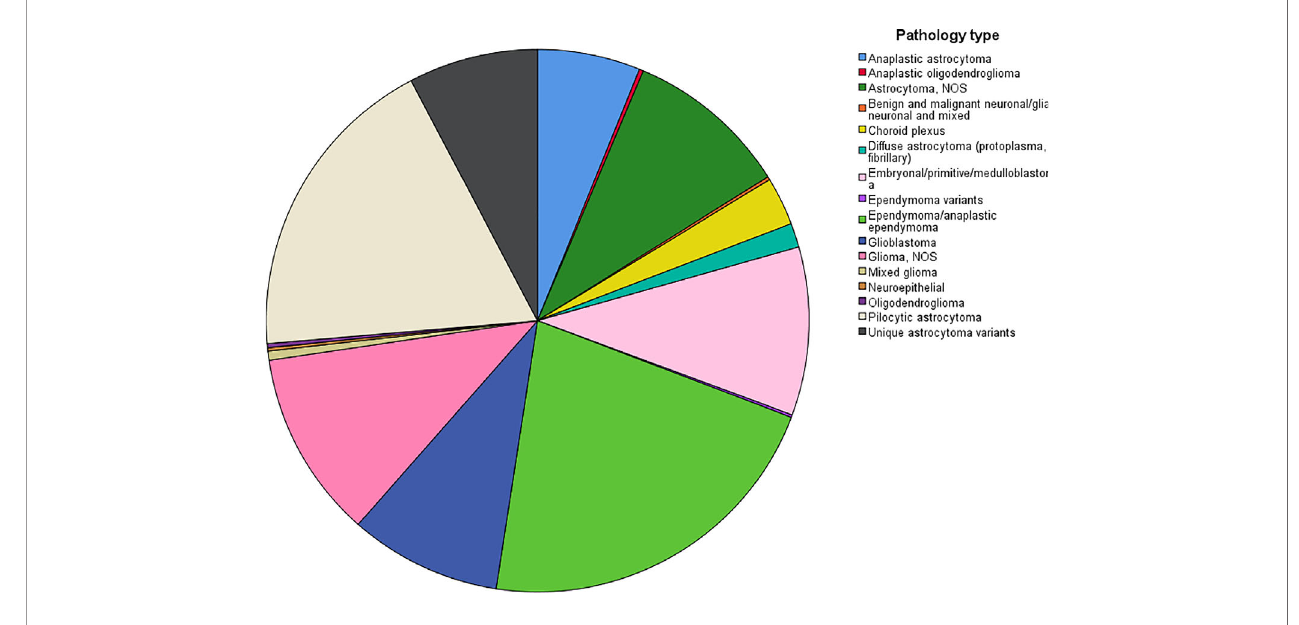
FIGURE 3 | The distribution of the patients with different pathological types.